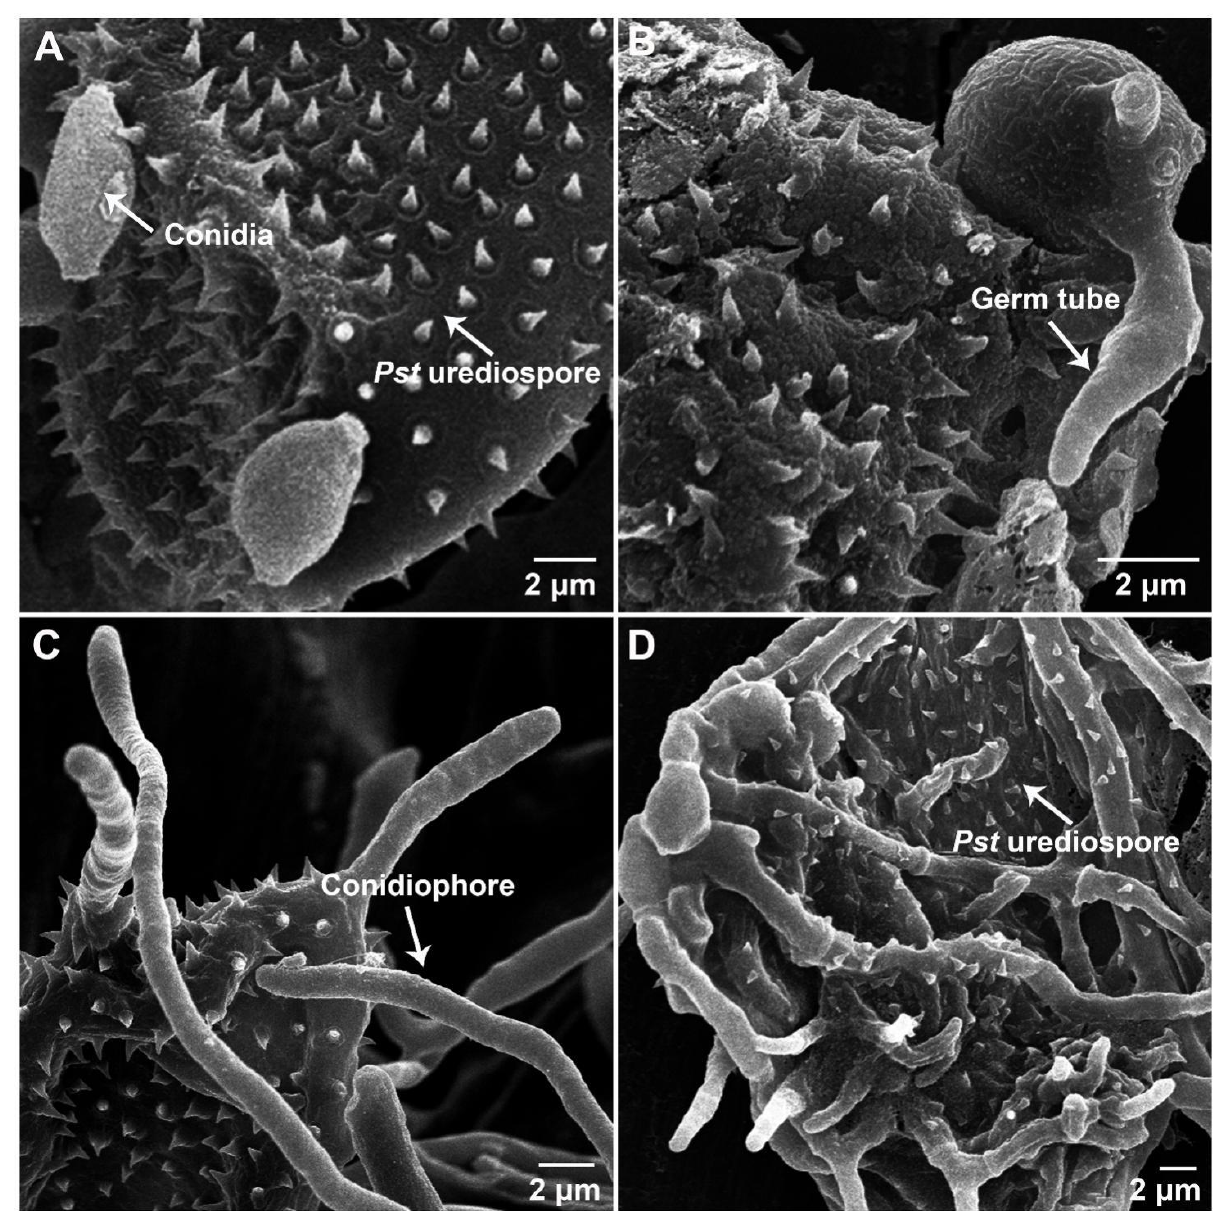
Figure 7. Morphologic characterization of Puccinia striiformis f. sp. tritici ( Pst ) urediospores infected by Cladosporium cladosporioides under a scanning electron microscope. ( A ), Conidia of C. cladosporioides on the surface of a Pst urediospore (×2000) at 12 hai (hours after inoculation); ( B ), at 36 hai, a C. cladosporioides conidium generated a germ tube (×4000); ( C ), at 72 hai, t C. cladosporioides produce conidiophores from the Pst urediospore (×3000); ( D ), at 120 hai, C. cladosporioides has completely colonized the Pst urediospore and the urediospore is destroyed (×1500).